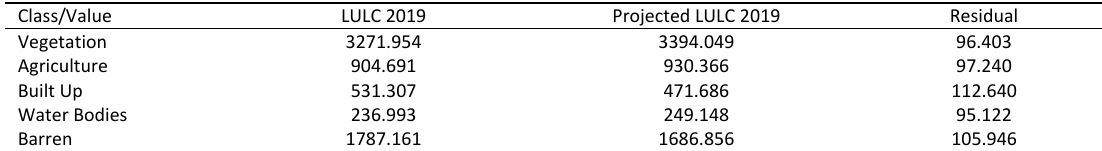
Table 4: Area of the land use classes (areas in km 2 )